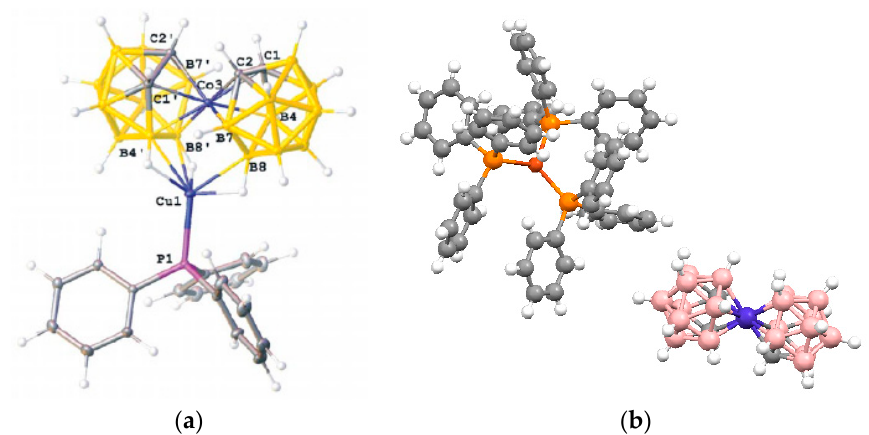
( a ) ( b ) Figure 122. X-ray structures of {(Ph 3 P)Cu)[3,3’-Co(1,2-C 2 B 9 H 11 ) 2 ]} ( a ) and [(Ph 3 P) 3 Cu][3,3’-Co(1,2-C 2 B 9 H 11 ) 2 ] ( b ). Reproduced with permission from reference [128]. Copyright © (2015) John Wiley & Sons, Inc.